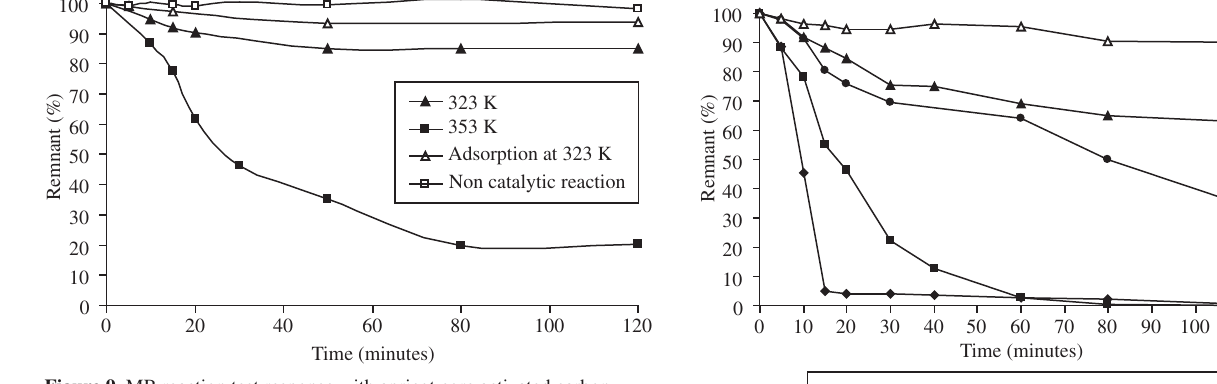
Figure 9. MB reaction test response with apricot core activated carbon.